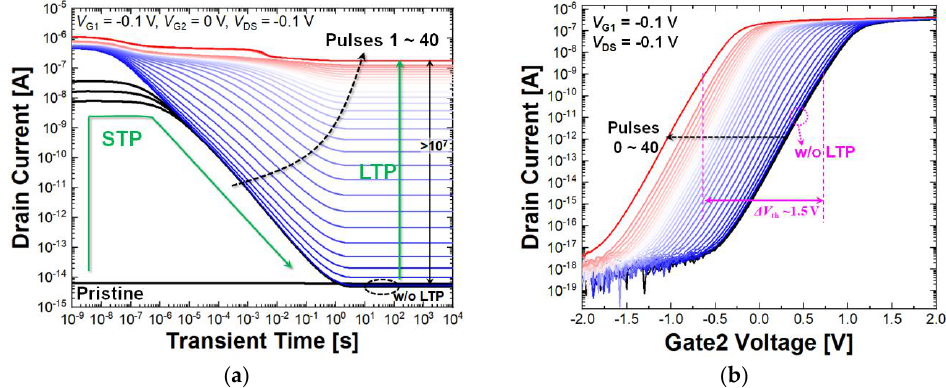
Figure 5. Electrical characteristics of the proposed synaptic device after different number of pulses: from 0 to 50 pulses. ( a ) Transient characteristics under read bias condition. ( b ) Transfer characteristics.